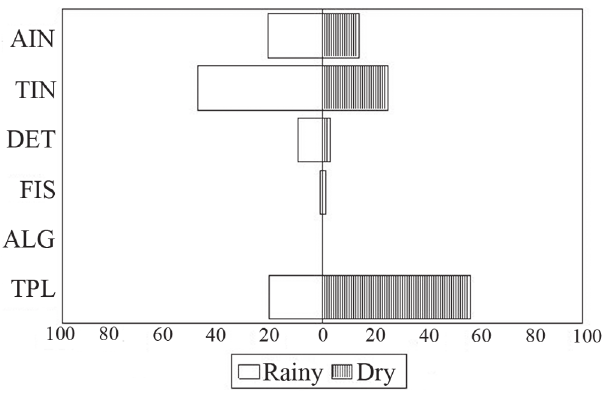
Fig. 6. Percentage composition of food resources consumed by fish species of Itiz stream, Ivaí River basin, Paraná State, Brazil, at site 3 in each hydrological period. AIN = aquatic invertebrates; TIN = terrestrial invertebrates; DET = detritus; FIS = fish; ALG = algae; TPL = terrestrial